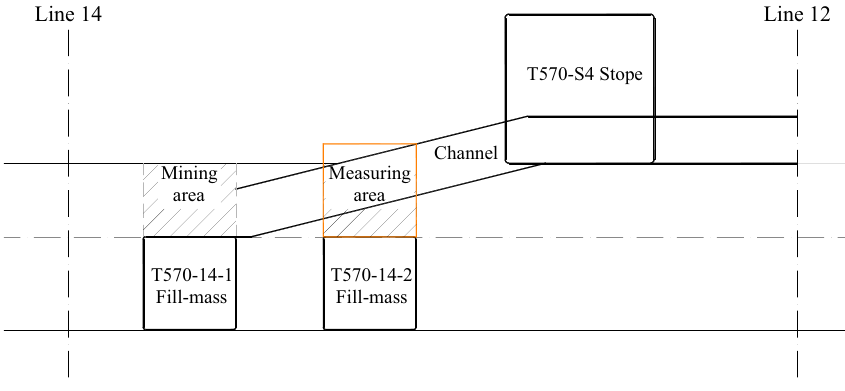
Figure 1. Section of horizontal line 12–14 slope at − 570 m.